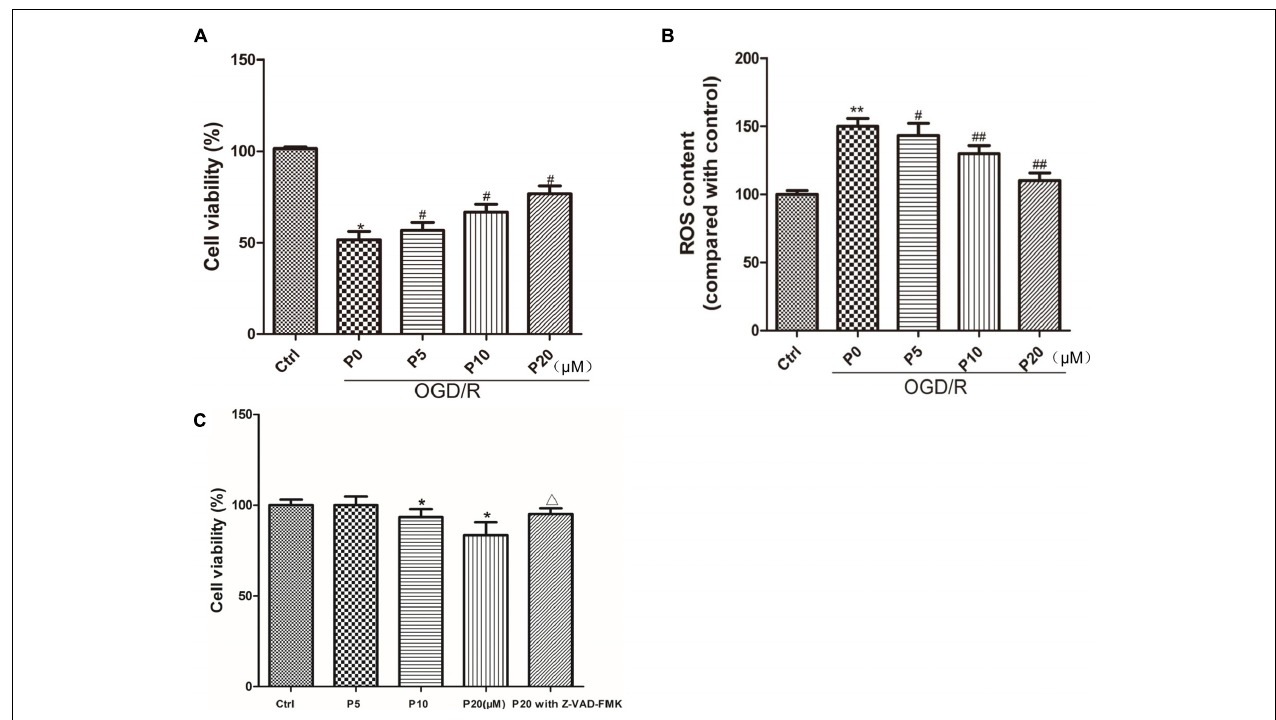
FIGURE 1 | Propofol enhanced the survival of H9c2 cells and decreased ROS level against OGD/R injury. Moreover, H9c2 cells proliferation under normal culture conditions was inhibited by propofol and caspase inhibitor relieved the effect of propofol. (A,C) Cell viability was assessed by measuring the CCK8. The viability of control group was defined as 100%. (B) Effects of propofol (5, 10, and 20 µ M) on increased intracellular ROS induced by OGD/R in H9c2 cells. The ROS contents of control group was defined as 100. The results were shown as mean ± SD from at least three independent experiments. ∗ P < 0.05, ∗∗ P < 0.01 versus control, # P < 0.05, ## P < 0.01 versus OGD/R group without propofol, (cid:49) P < 0.05 versus 20 µ M propofol